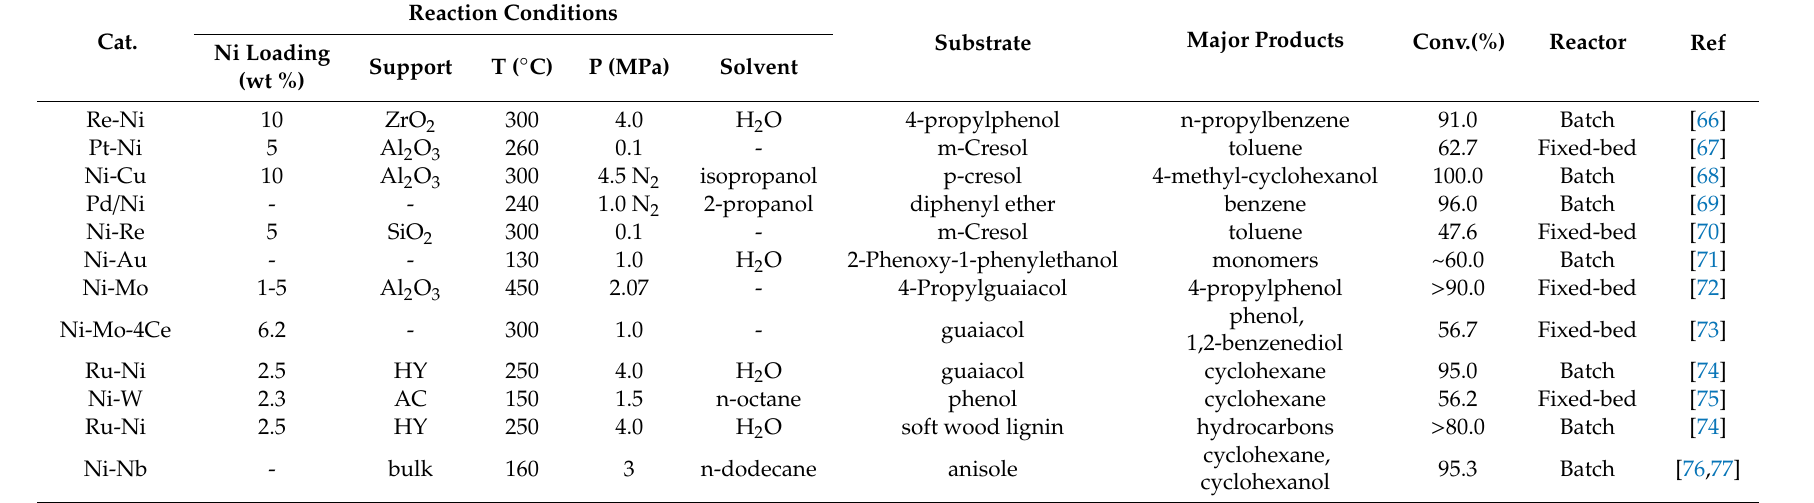
Table 4. HDO of lignin model compounds and lignin over Ni-based bimetallic